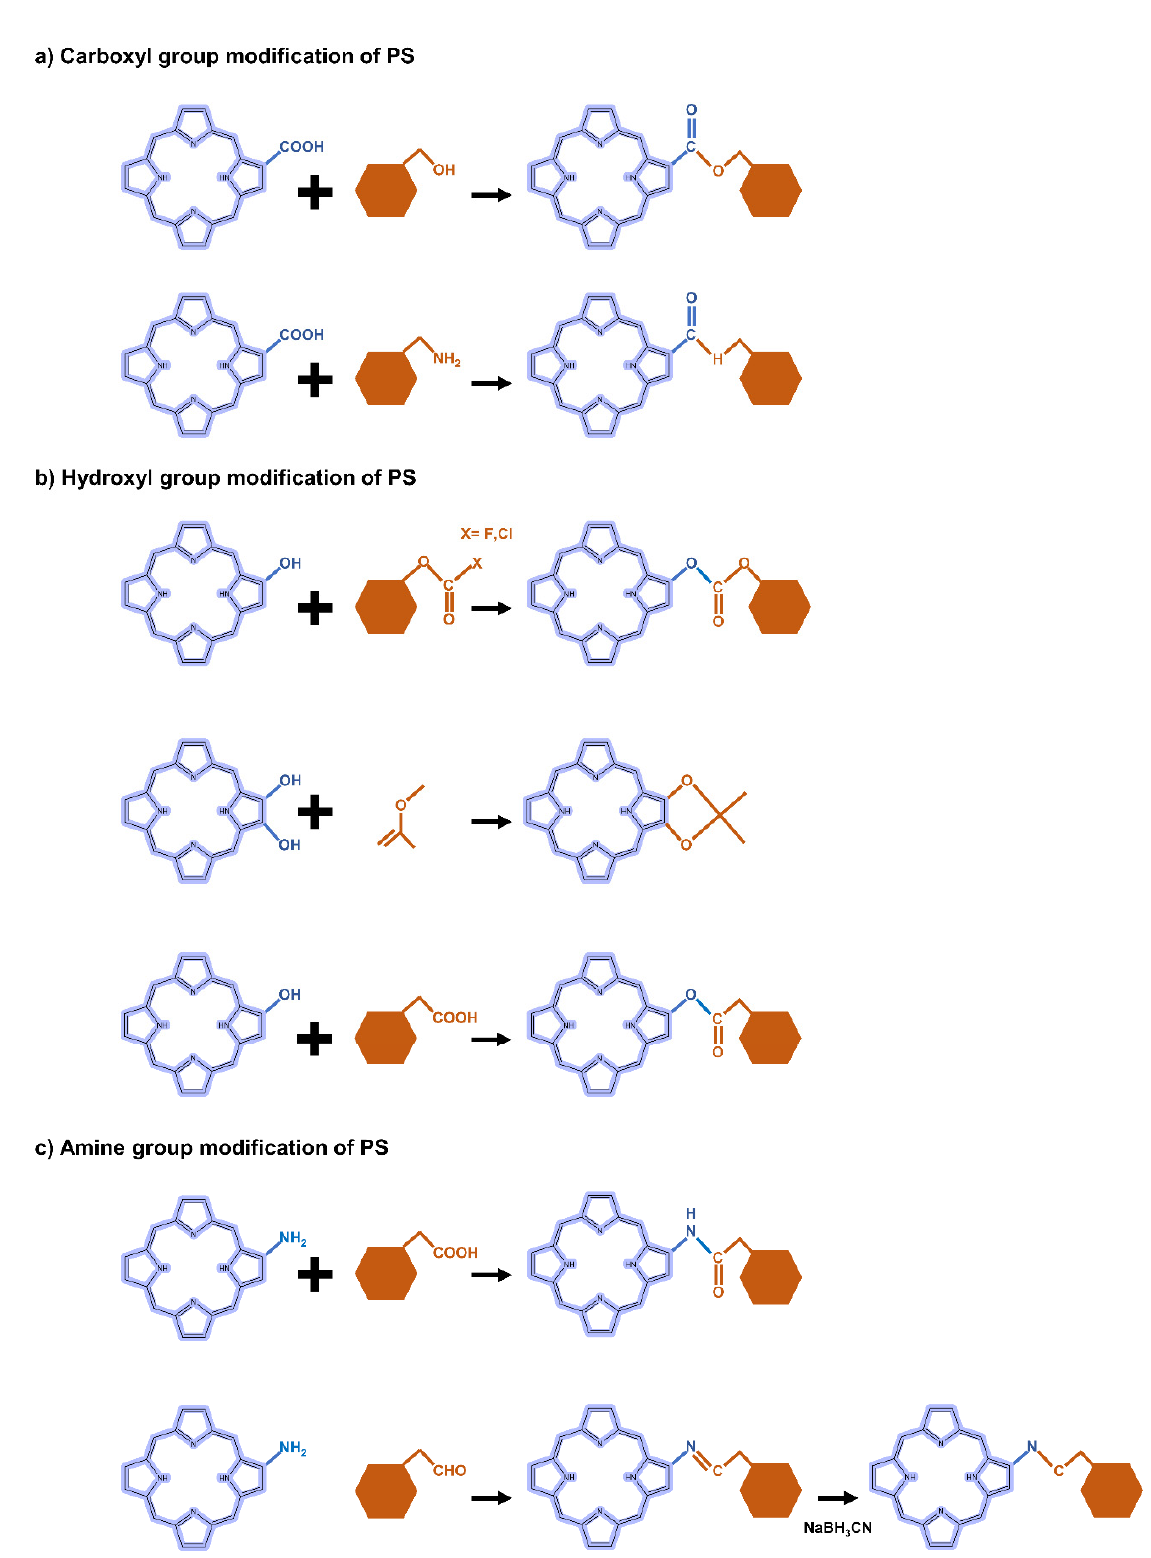
Figure 3. Representative reactions to modify the functional groups of PS-derivative based on ( a ) carboxyl, ( b ) hydroxyl, and ( c ) amine. ( a ) carboxyl, ( b ) hydroxyl, and ( c )